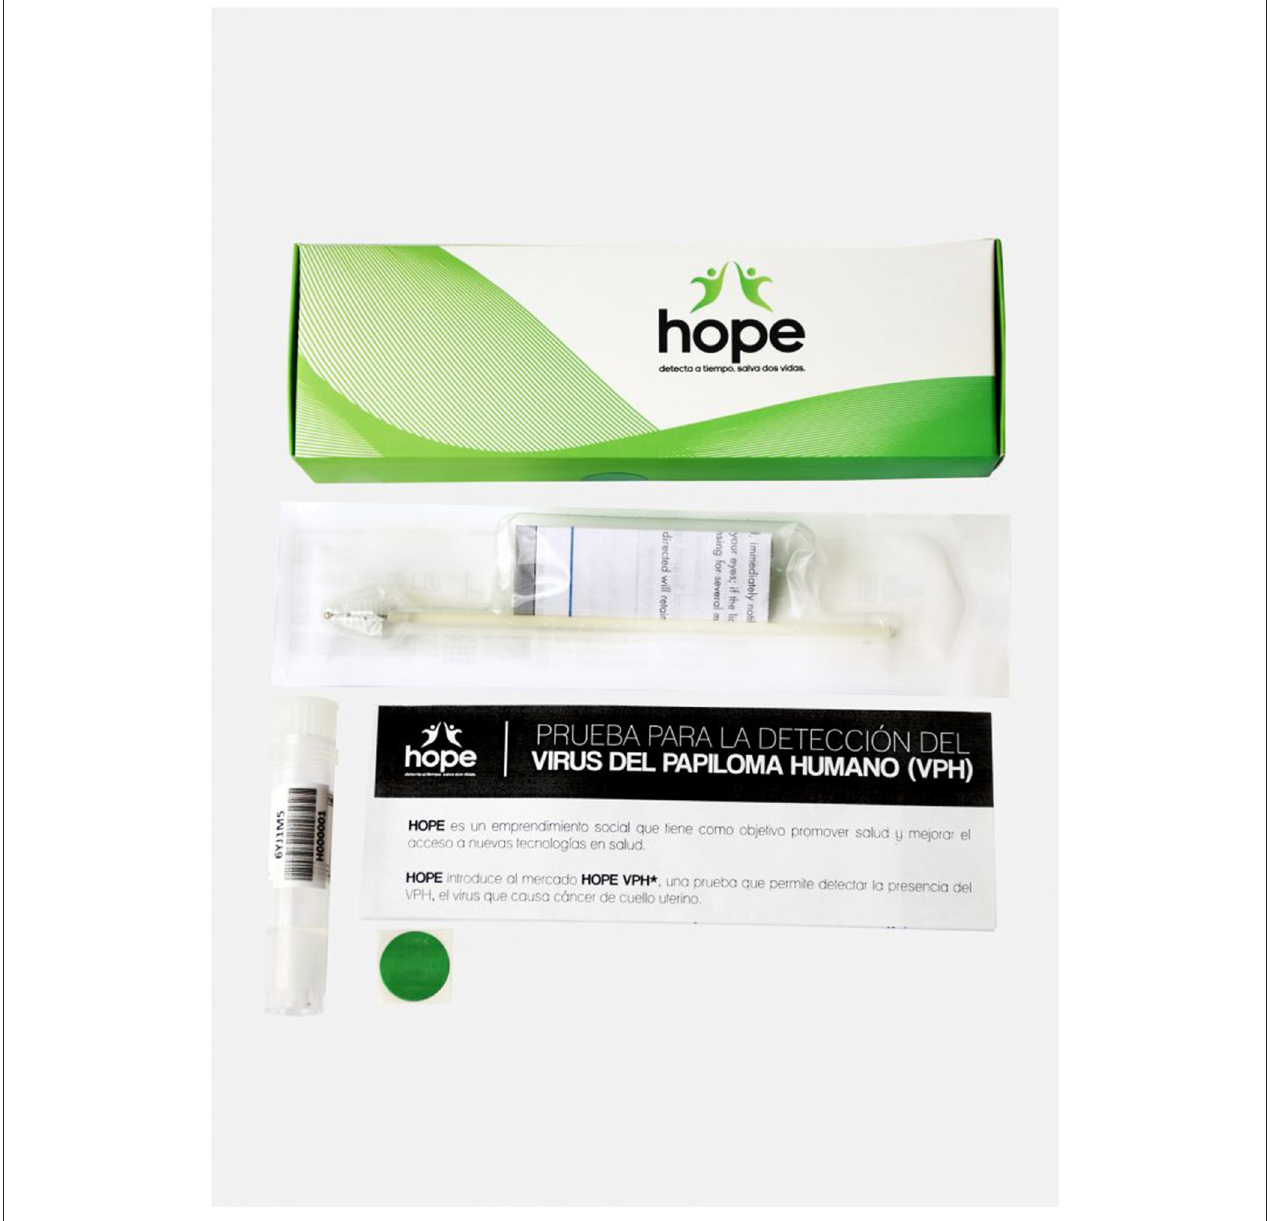
FIGURE 2 | HPV self-sampling kits sold by the Hope